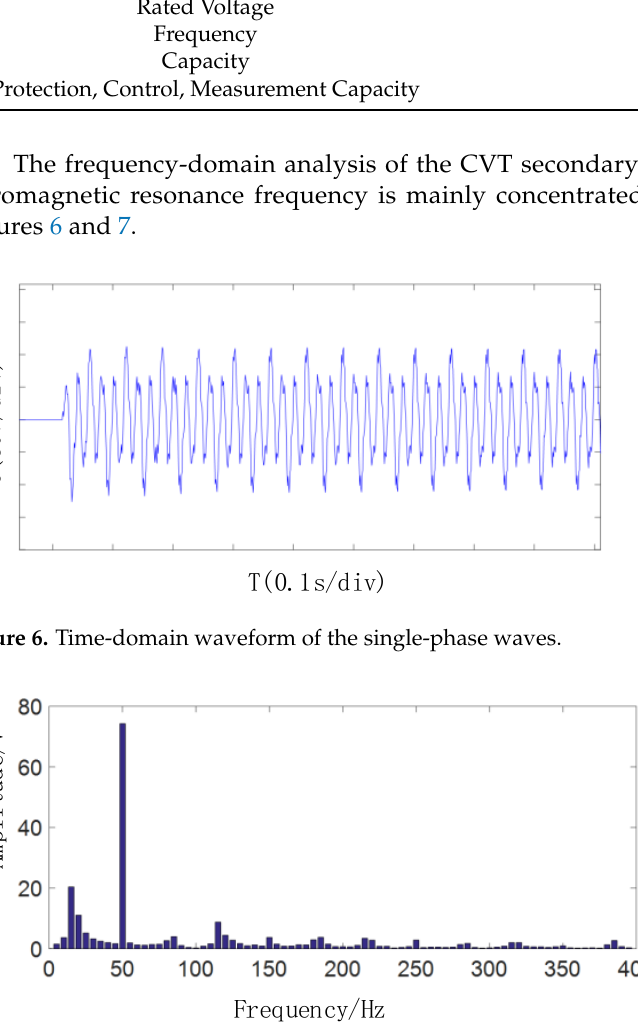
Table 1. Nameplate parameters of CVT.